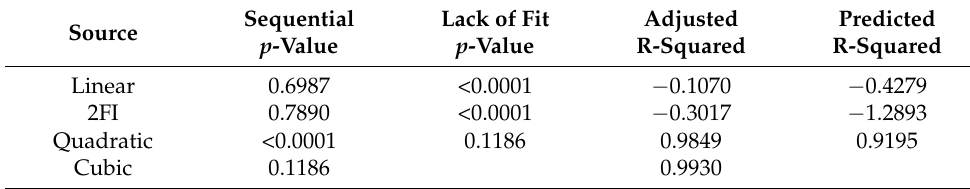
Table 4. Fitting model for the validation.